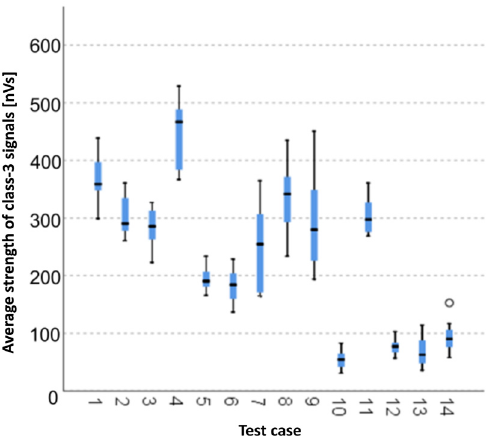
Figure 9. Graphic presentation of the Kruskal–Wallis test results for independent samples: average strength of class-3 signals.